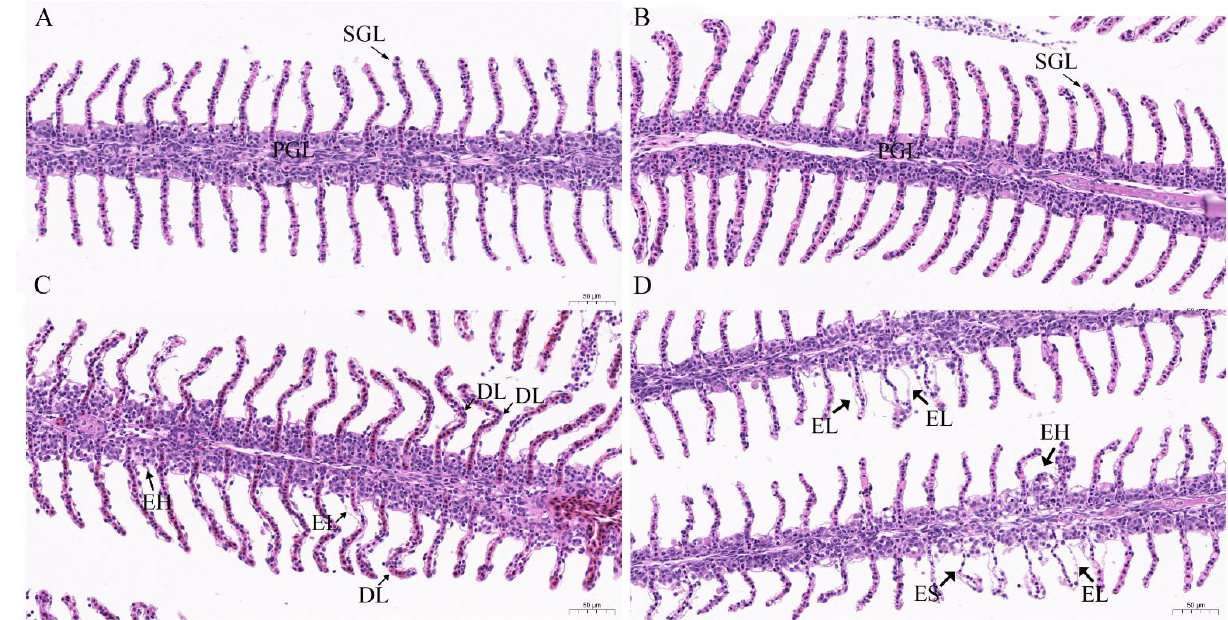
Figure 6. Histopathological analysis in the gills of goldfish ( Carassius auratus ) after exposure to 0.81 mg/L trichloroisocya- nuric acid. ( A ) goldfish gills of the control group (0 mg/L TCCA), primary gill lamellae (PGL) and secondary gill lamellae (SGL); ( B ) goldfish gills exposed to 0.81 mg/L TCCA for one day, primary gill lamellae (PGL) and secondary gill lamellae (SGL); ( C ) goldfish gills exposed to 0.81 mg/L TCCA for two days, epithelial hyperplasia (EH), epithelial lifting (EL), and deformed lamellae (DL); ( D ) goldfish gills exposed to 0.81 mg/L TCCA for four days, epithelial hyperplasia (EH), epithelial lifting (EL), and epithelial shedding (ES).